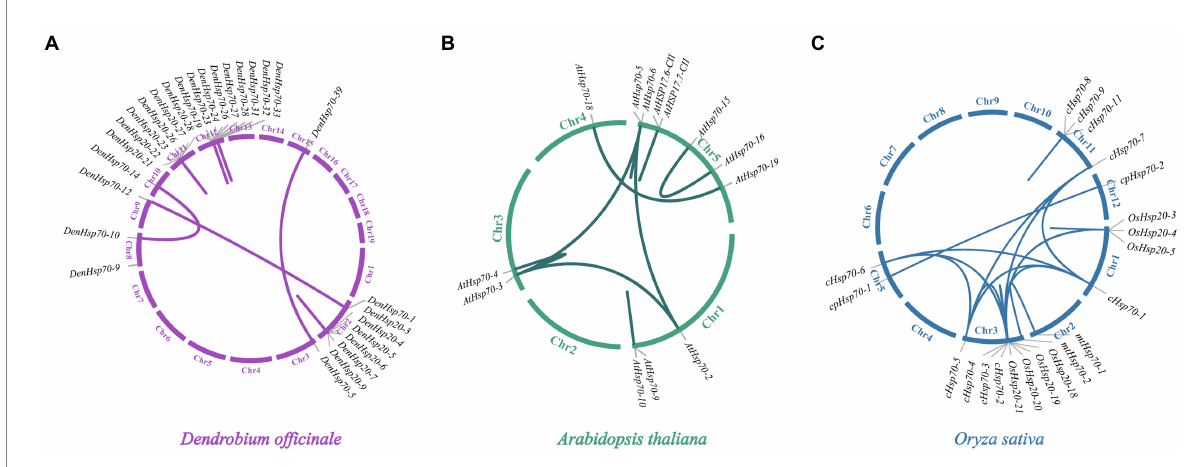
FIGURE 4 Schematic representations of the gene duplications of Hsp20 , Hsp70 and Hsp90 genes from three different plants. (A–C) represent the syntenic gene pairs in D. officinale , A. thaliana and O. sativa , respectively.